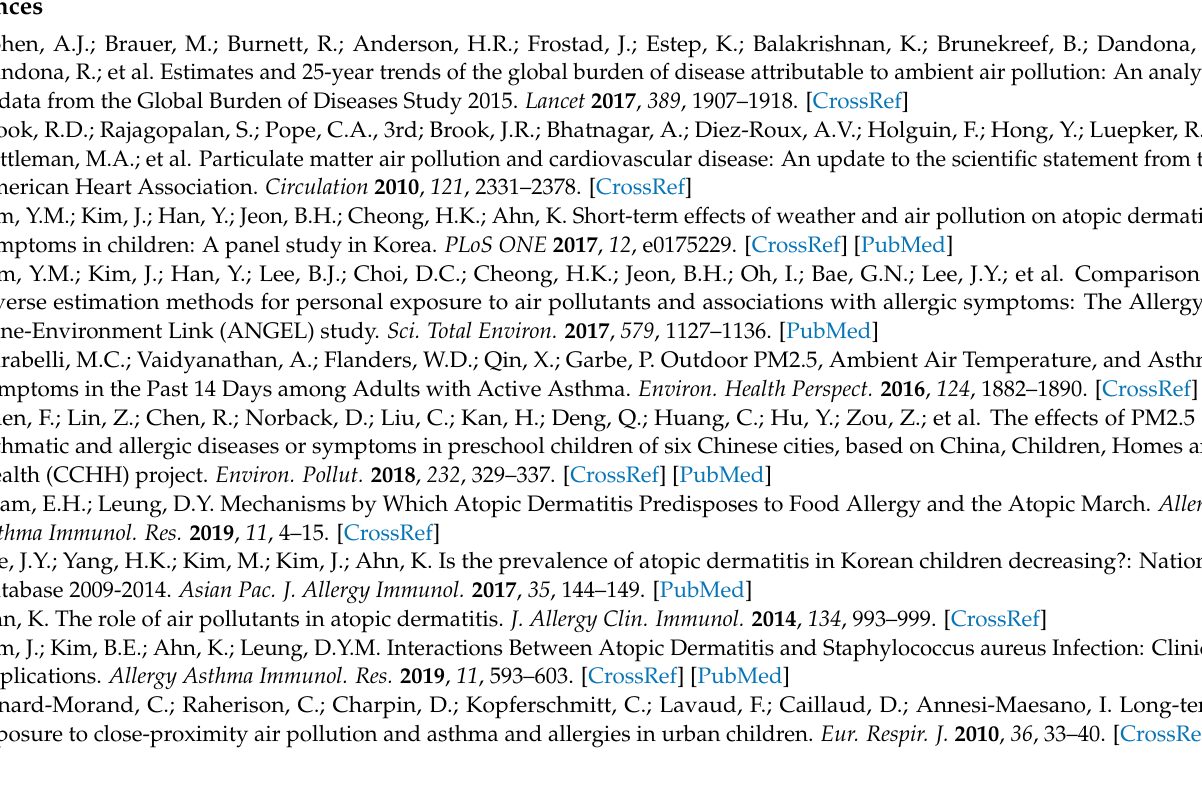
during study period, Table S5: Characteristics of AD patients and indoor environments by age group, Figure S1: Comparison of the PM 2.5 concentrations measured by SSP100 with those by Grimm PAS, Figure S2: Correlations between atopic dermatitis (AD) symptoms and environmental